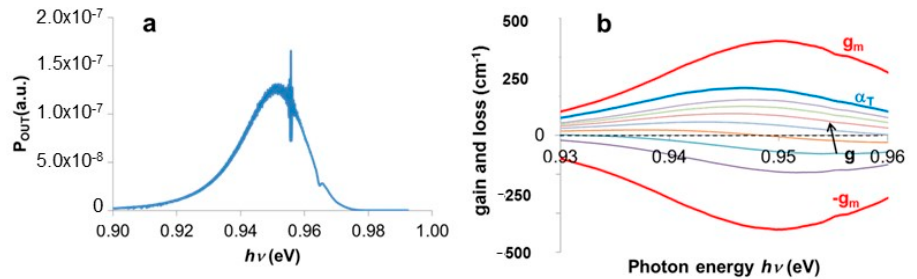
Figure 16. ( a ) One of the spectra of the DFB laser with a non-resonating cavity; ( b ) gain curves for the non-reflecting cavity.